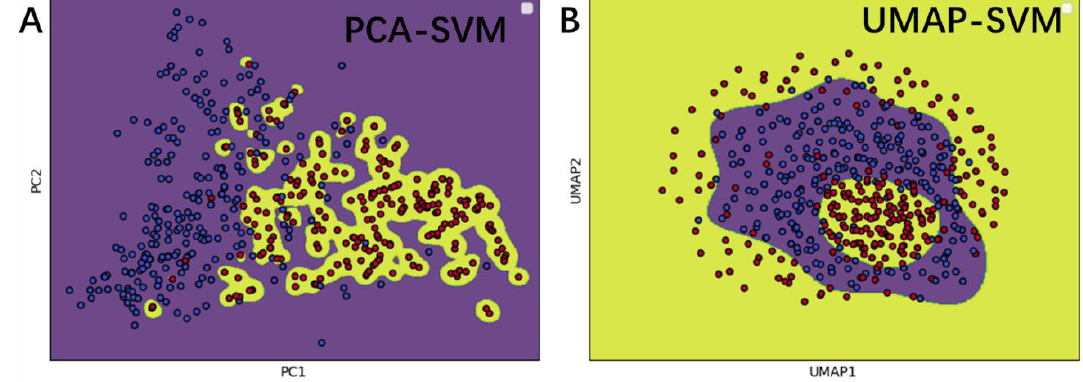
Figure 5. Dimension reduction visualization of umami peptide BERT features and decision function boundary analysis of the SVM model. The red dots are umami peptides and the blue dots are non-umami peptides. The sub-figure ( A , B ) show the use of principal components analysis (PCA) and uniform manifold approximation and projection (UMAP) respectively for reducing 139 dimensional selected BERT features to 2 dimensions for visual analysis. Additionally, the decision function boundary lines of support vector machine (SVM) are drawn in both. The yellow section represents the positive sample area and the purple section represents the negative sample area.